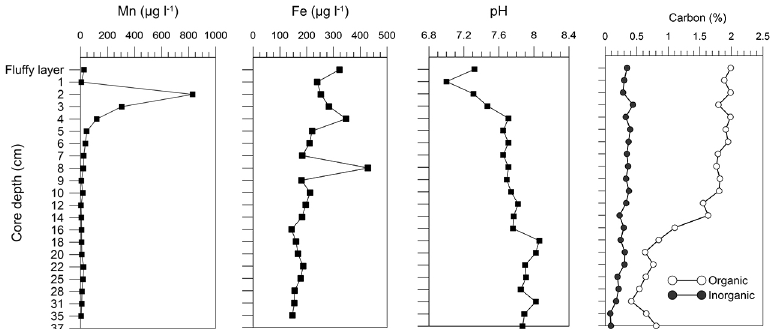
Figure 13. Concentrations of dissolved Mn ( a ), Fe ( b ), and pH values ( c ) in the pore water, as well